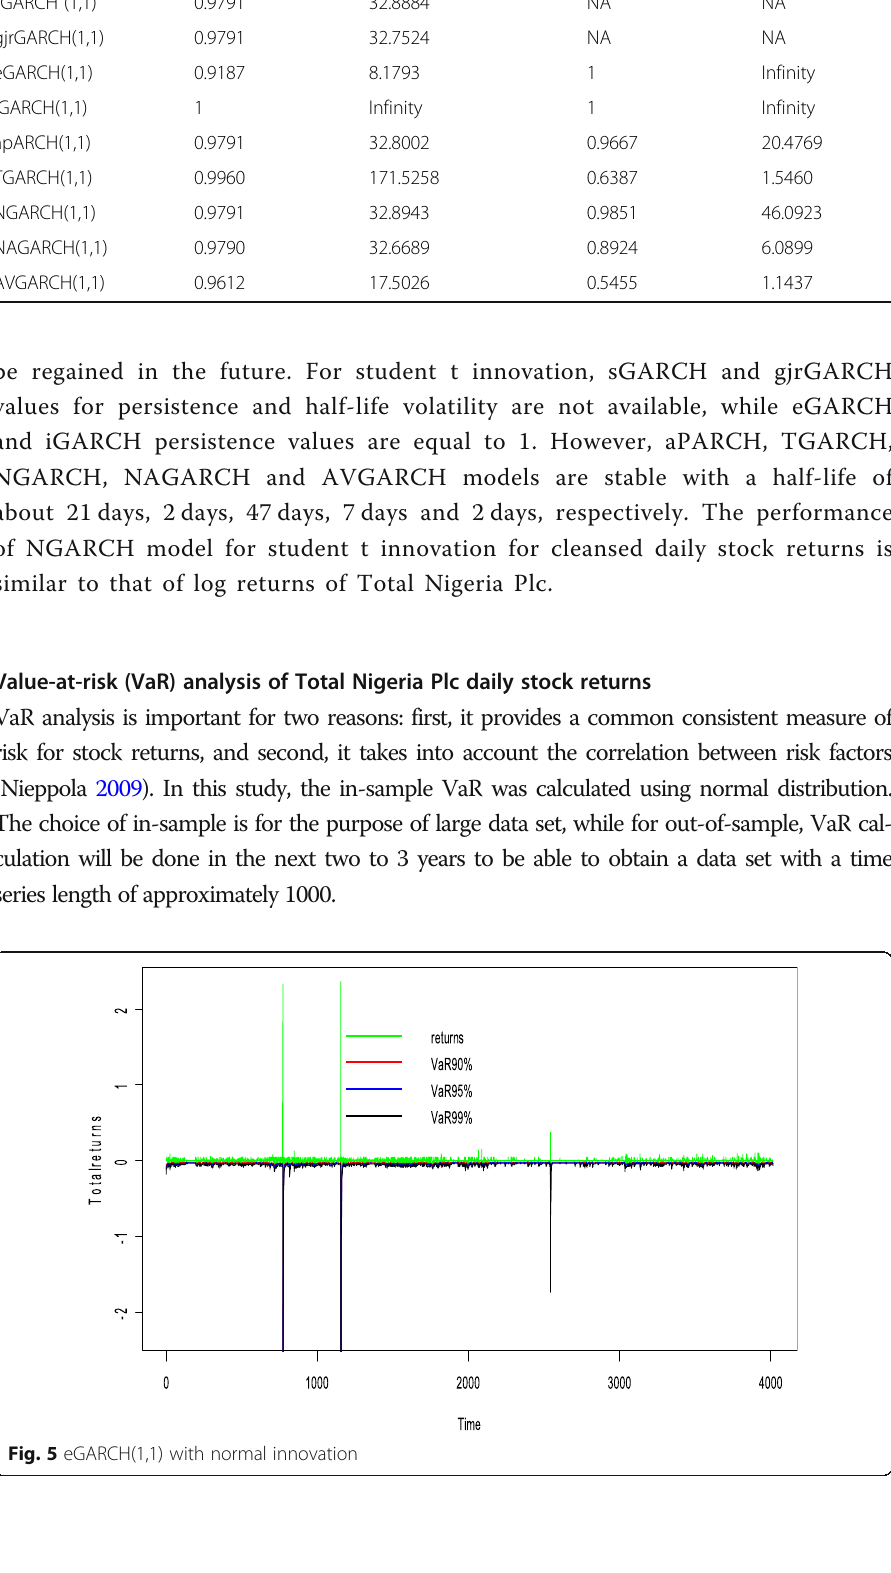
Table 6 Persistence and half-life volatility of the cleansed log returns of daily stock price of Total Nigeria Plc Normal innovation Student t innovation Persistence Half-life volatility Persistence Half-life volatility